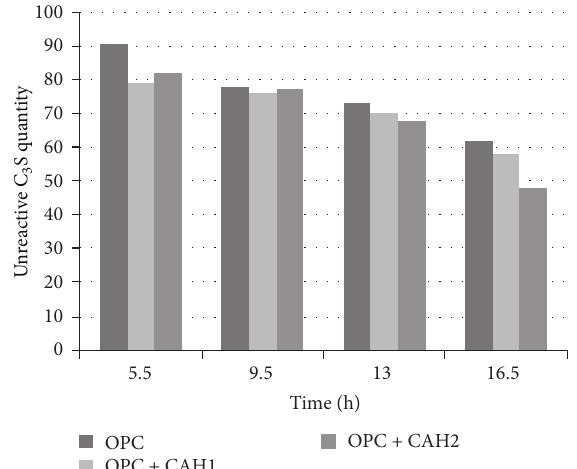
Figure 3: The quantity of unreactive C 3 S in pure OPC, OPC-CAH1, and OPC-CAH2 samples after different duration of